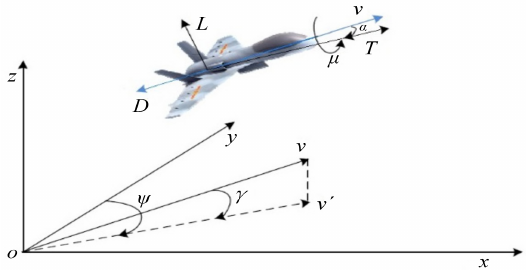
Figure 4. Schematic diagram of UCAV pseudo-six degrees of freedom